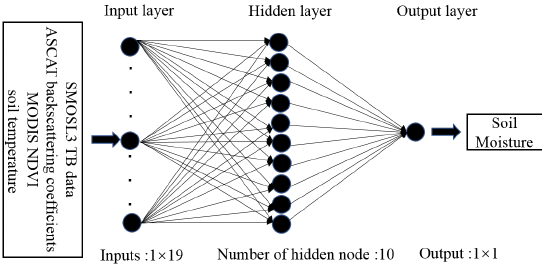
Figure 1. The architecture of the NN